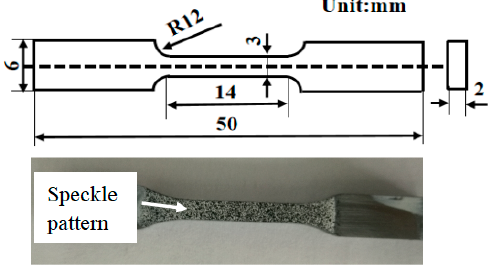
Figure 3. The size and surface treatment condition of the specimen.